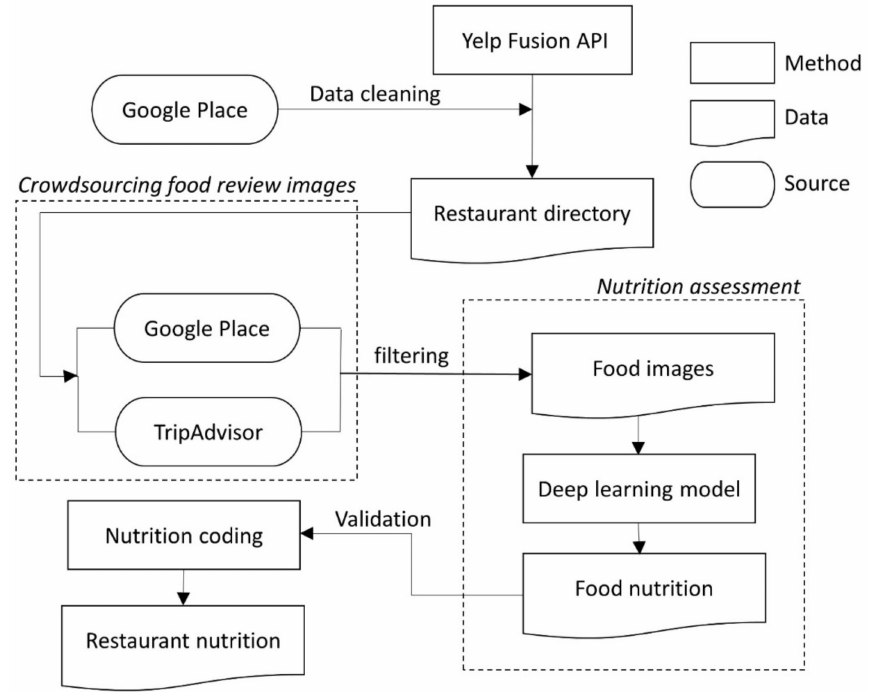
Figure 3. Flowchart of nutrition assessment by the deep learning